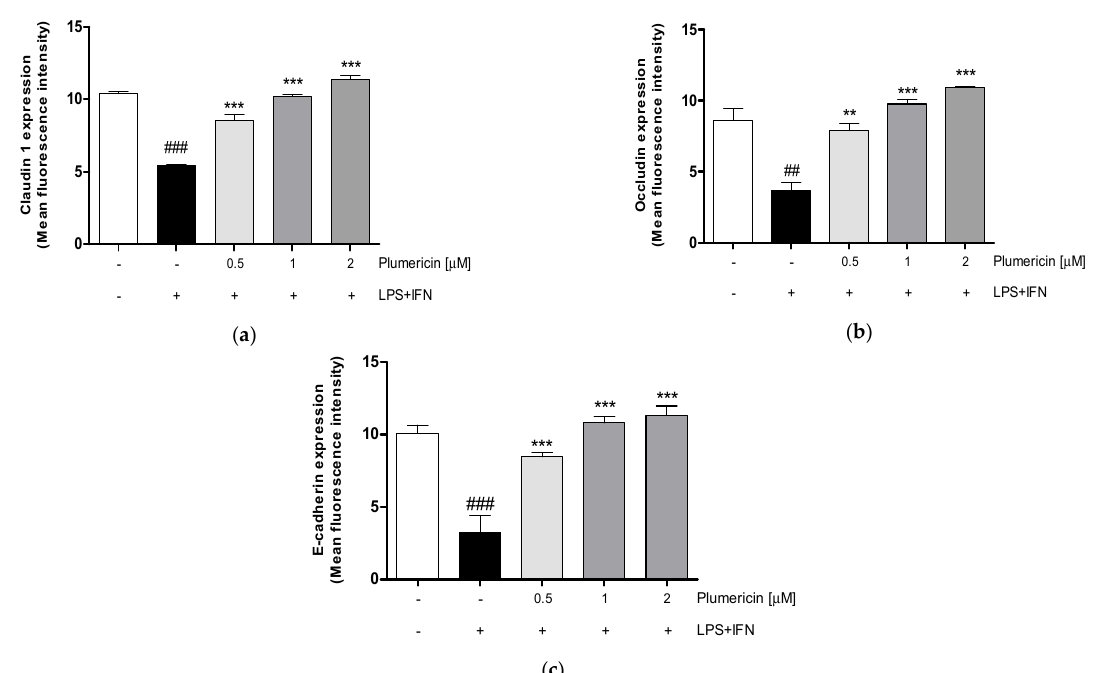
Figure 1. Effect of plumericin on adhesion molecules: Claudin 1 ( a ), Occludin ( b ), and E-cadherin ( c ) expression in LPS + IFN-stimulated IEC-6, evaluated by flow cytometry. Values are expressed as mean ± SEM of mean fluorescence intensity. ### and ## denote, respectively, p < 0.001 and p < 0.01 vs. untreated cells; *** and ** indicate, respectively, p < 0.001 and p < 0.01 vs. LPS + IFN.